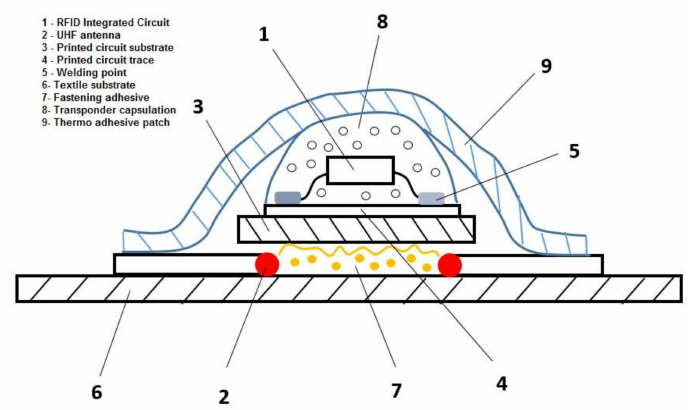
Figure 8. Detail with the components of the proposed passive UHF RFID tag.